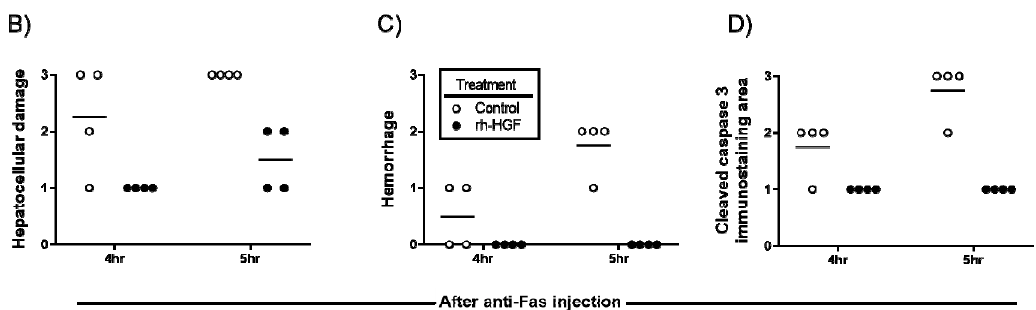
Figure 3. Histological analysis of anti-Fas antibody-induced mouse ALF livers. ( A ) Representative images of the livers from PBS (control, left rectangle) or rh-HGF (right rectangle) treated mice are shown at low (upper panels) or high magnification (lower panels) with hematoxylin-eosin (HE) staining. Dotted rectangles in upper panels were magnified into lower panels. Further magnified images (insets in the lower panels) were derived from the rectangle in lower panels to show representative lesion of intrahepatic hemorrhage and to compare its severity with rh-HGF treated mice. Scale bars, 200 µm. ( B ) The degree of hepatocellular damage was scored qualitatively as unremarkable, slight, moderate, or marked, noted as 0, 1, 2, or 3, respectively. ( C ) The degree of hemorrhage was also scored qualitatively as no hemorrhage, slight hemorrhage, moderate hemorrhage, or marked hemorrhage as 0, 1, 2, or 3, respectively. ( D ) The degree of cleaved caspase-3 immunostaining area (%) was classified as 0%, 0–10%, 10–30%, or over 30% as 0, 1, 2, or 3, respectively. Control (PBS, open circles) or rh-HGF (1.5 mg/kg, closed circles) was administered to the mice. hr: hour.